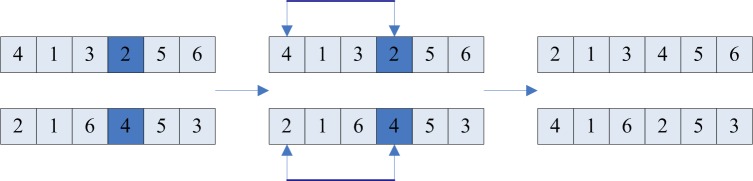
Crossover operation.